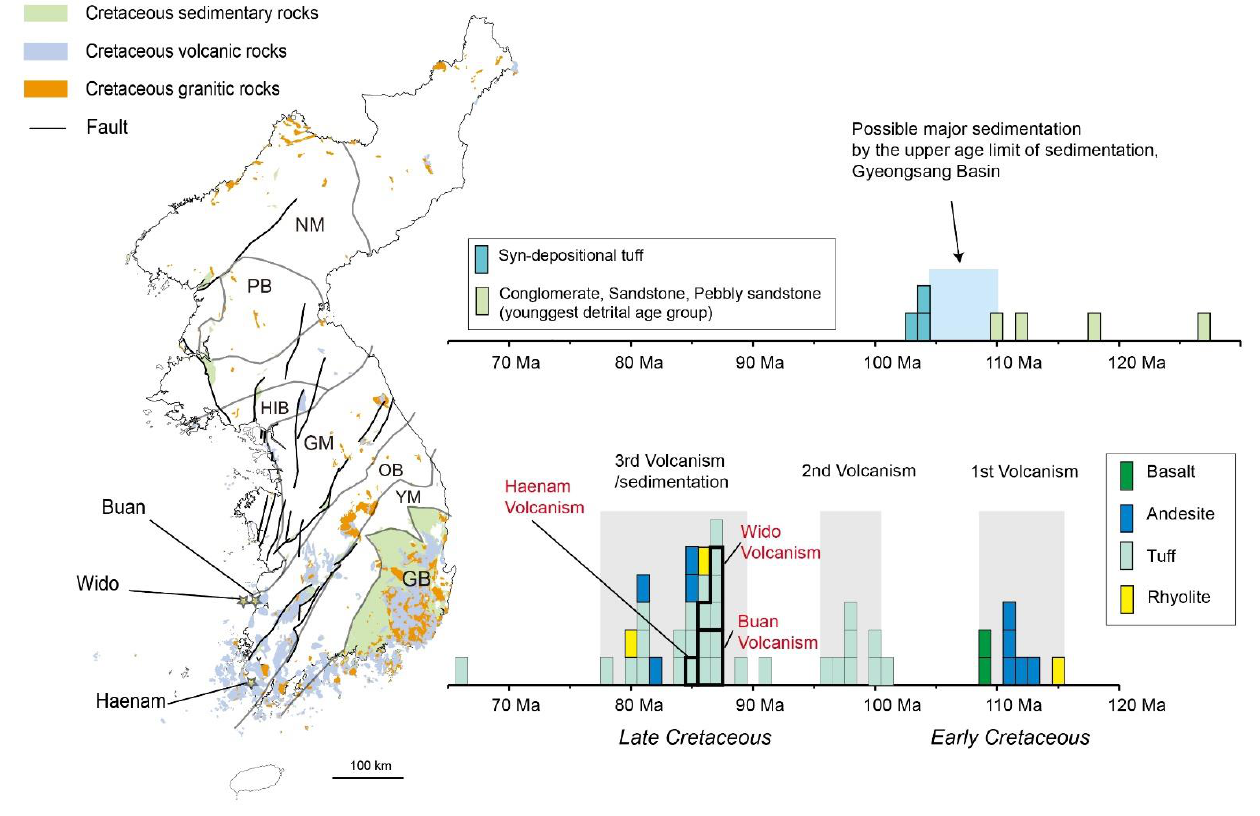
Figure 11. Frequency distribution diagrams of SHRIMP and IDTIMS zircon U–Pb ages for the Cretaceous volcanic and sedimentary rocks by the rock occurrence patterns throughout the Korean Peninsula.